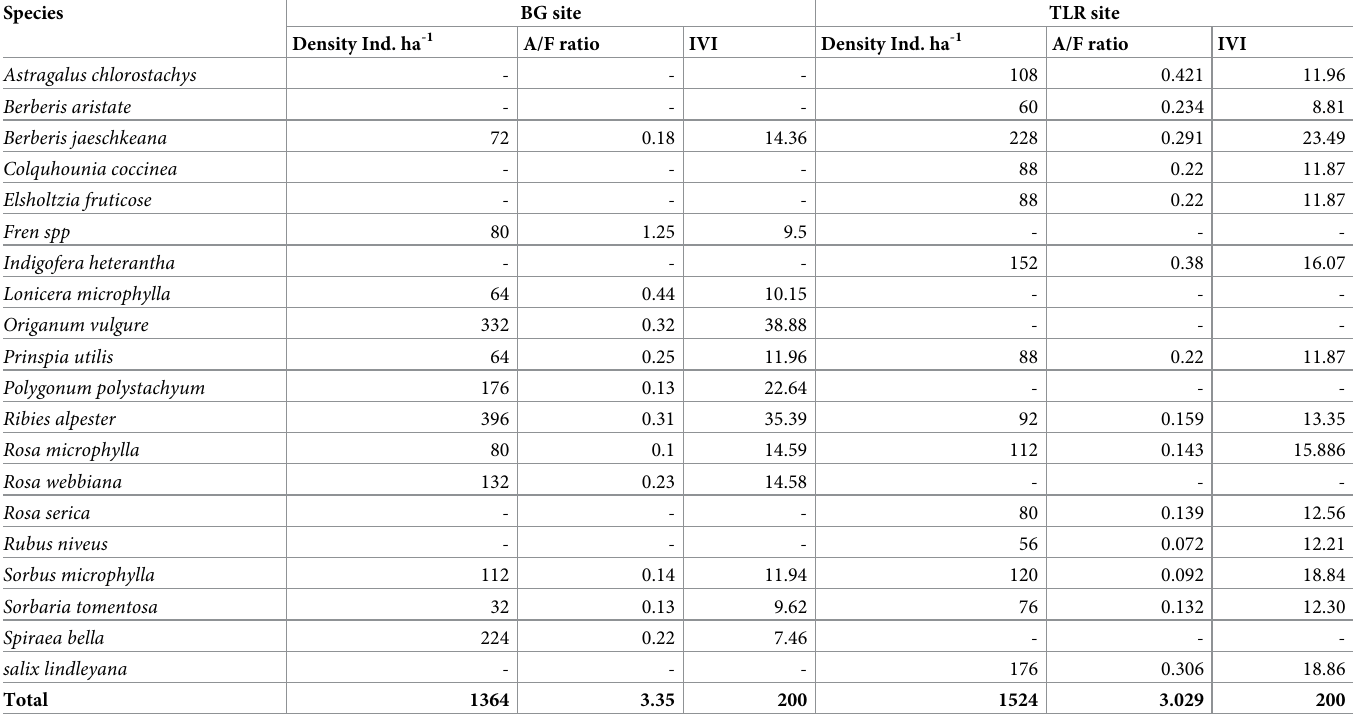
Table 3. Phytosociological parameters of shrub species around temperate zone of Nanda Devi Biosphere Reserve, Western Himalaya.